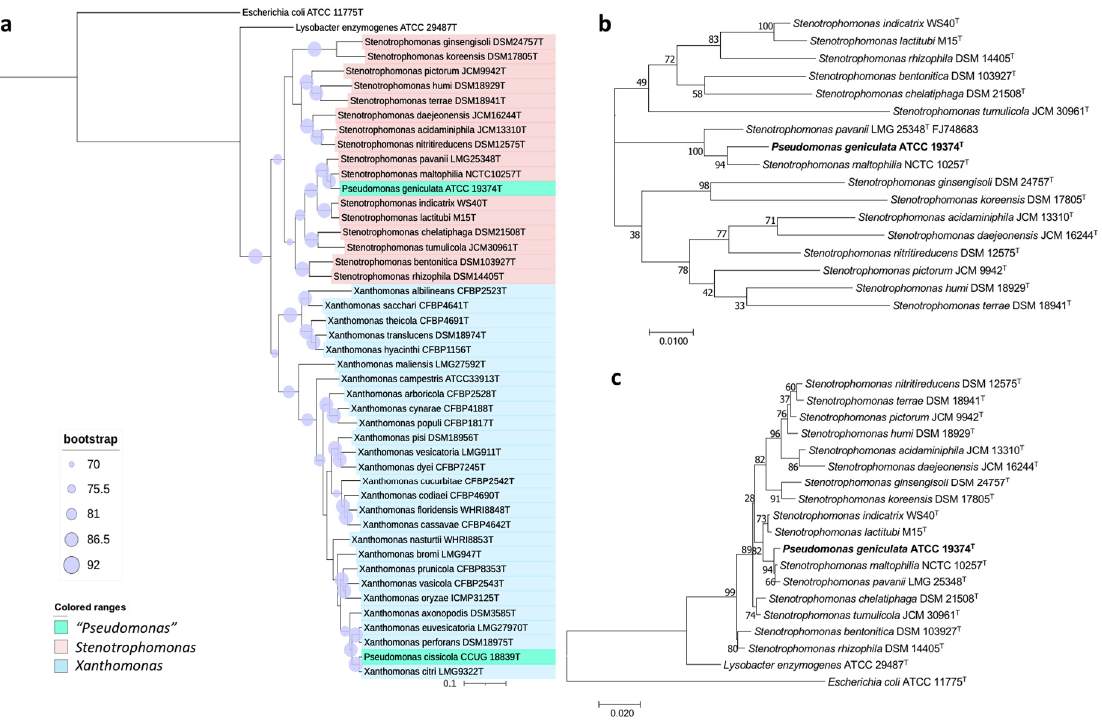
Figure 4. Phylogenetic trees built to study the taxonomic placement of P. geniculata ATCC 19374 T based on ( a ) 92 housekeeping genes, ( b ) 16S rRNA and gyrB concatenated genes, ( c ) the 16S rRNA gene. Scale bars = 1 nucleotide (nt) substitution per 100 nt. Blue circles represent bootstrap values, which indicate the number of individual phylogenetic trees of each of the 92 genes that support each branch (Gene Support Index). Bootstrap value of 92 means that the branch is supported by all UBCG phylogenies.